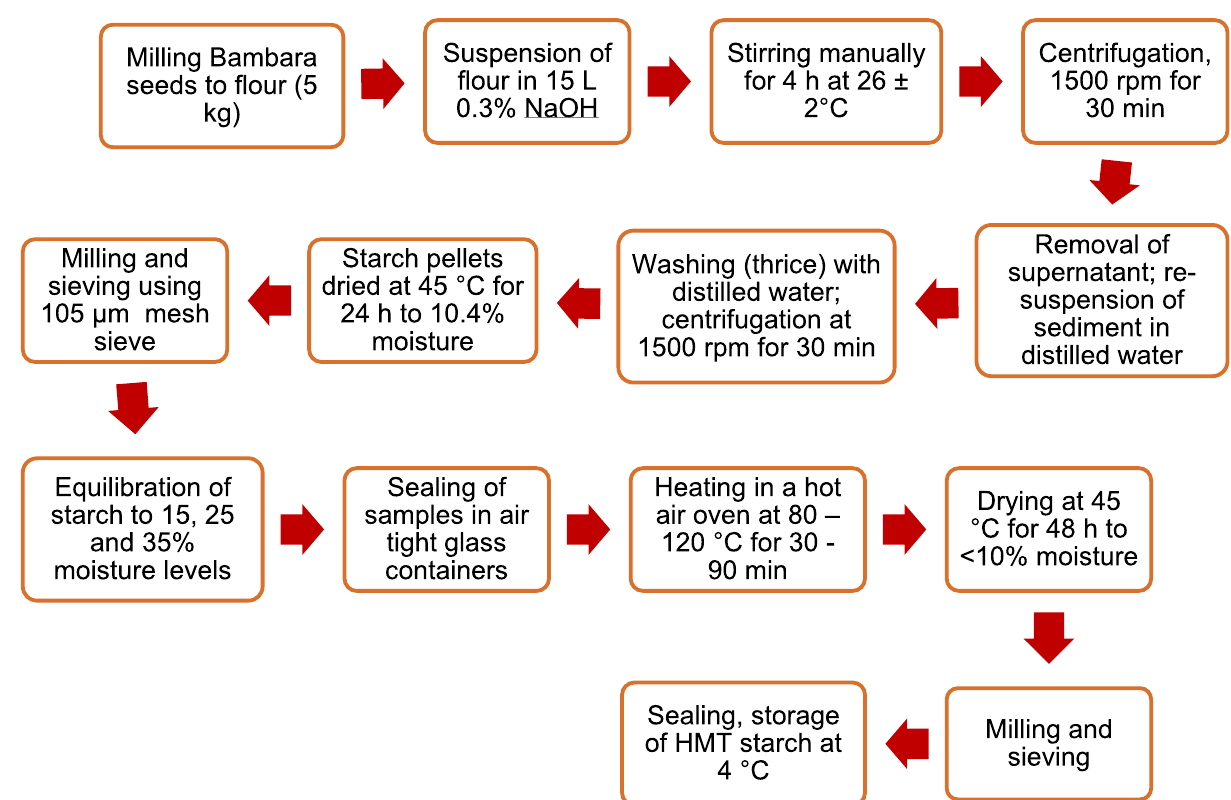
Figure 1. Bambara groundnut starch extraction and heat-moisture treatment of the extracted